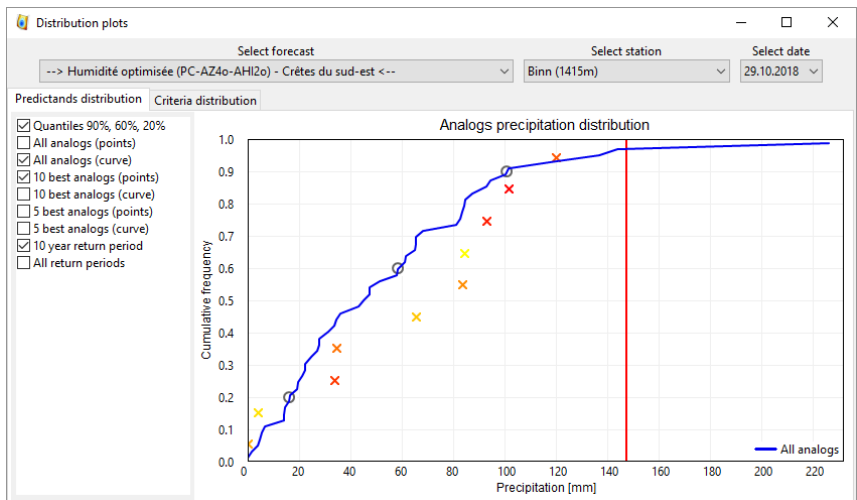
Figure 7. Visualization of the forecasted precipitation distribution for a given lead time for an event at the Binn station (Fig. 1) in October 2018. The blue line represents the full distribution provided by all analogs, the circles are the 90th, 60th, and 20th percentiles, and the crosses correspond to the distribution provided by the 10 best analogs (with a color gradient from red for the best to yellow for the 10th). The vertical red line here is the precipitation value for a 10-year return